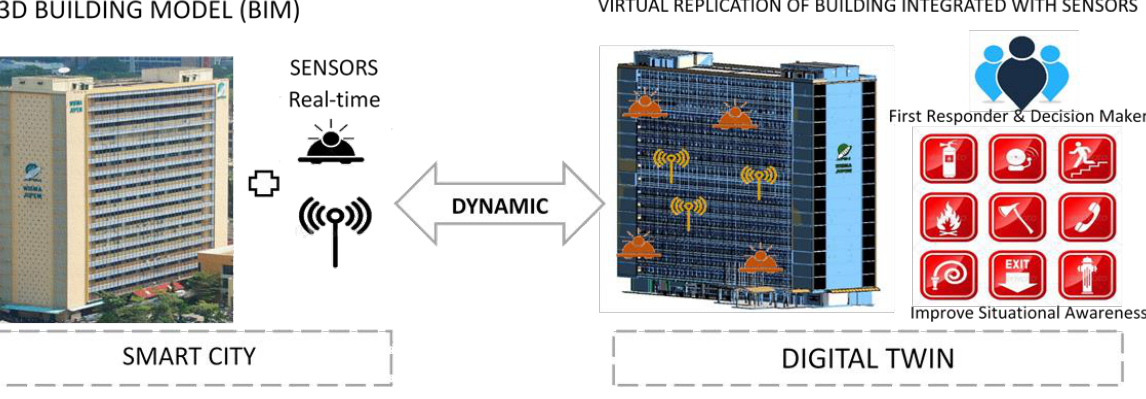
Figure 5 . Proposed conceptual framework to create smart city digital twin for indoor hazard Source of building: Department of Survey and Mapping